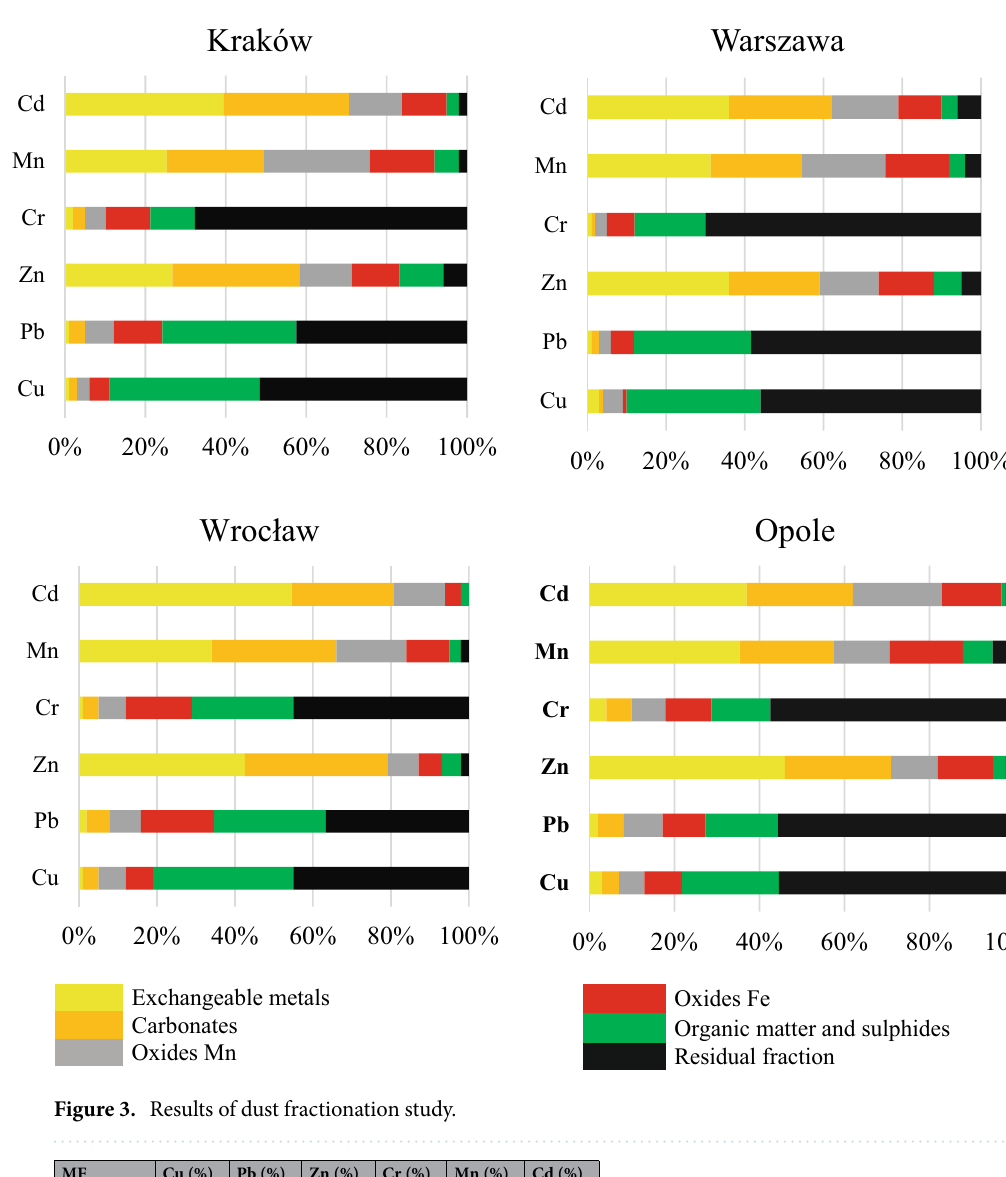
Figure 3. Results of dust fractionation study.